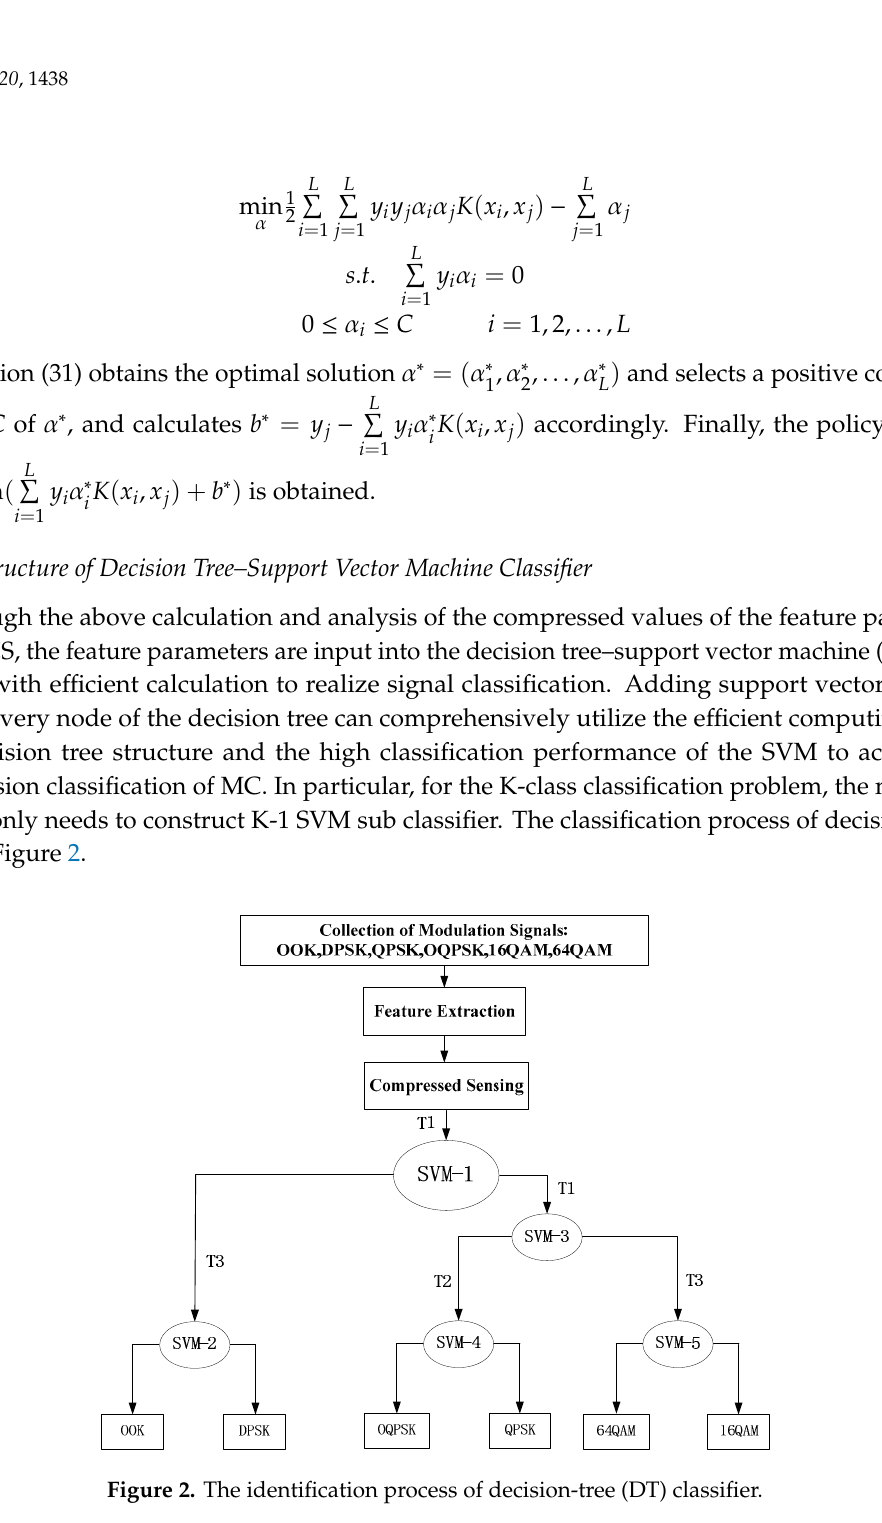
Figure 2. The identification process of decision-tree (DT) classifier.